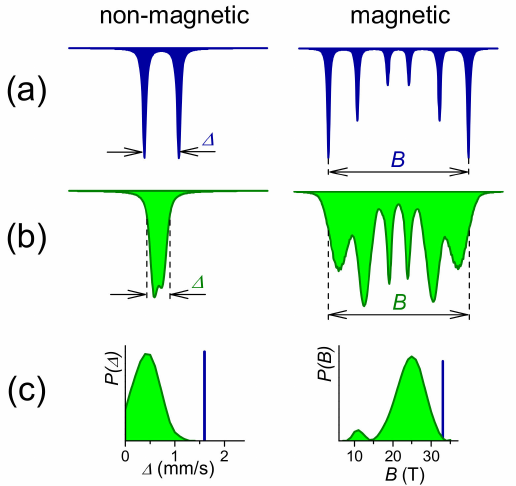
Figure 1. Simulated 57 Fe Mössbauer spectra of: ( a ) Crystalline material; ( b ) disordered or amorphous material; ( c ) corresponding hyperfine parameters including quadrupole splitting, ∆ , and hyperfine magnetic field, B , together with their distributions P ( ∆ ) and P ( B ),